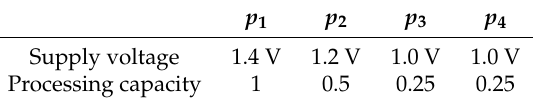
Table 9. Processor properties.